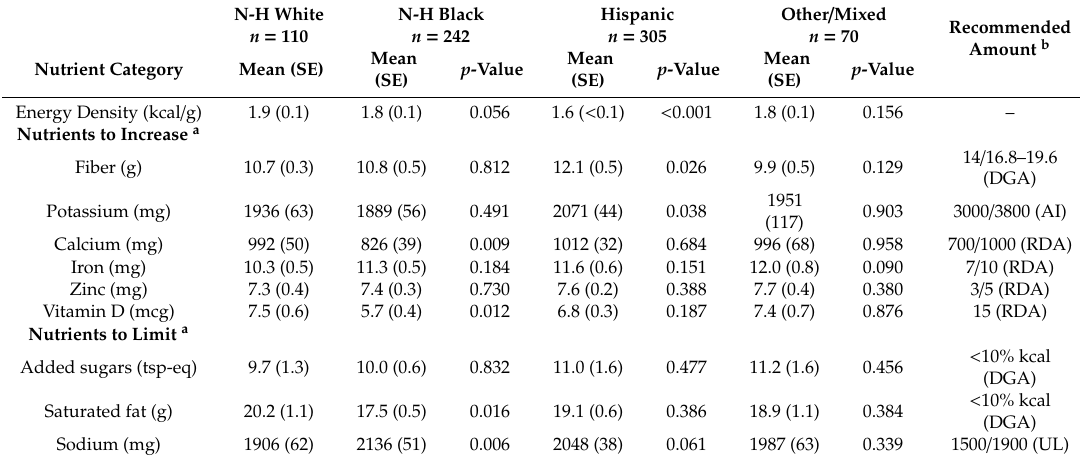
Table 2. Racial / ethnic di ff erences in nutrient intake of WIC-participating children 1–4 years of age in the NHANES 2011–2014 ( N = 727). N-H White N-H Black Hispanic Other / Mixed n = 110 n = 242 n = 305 n = 70 Recommended Amount